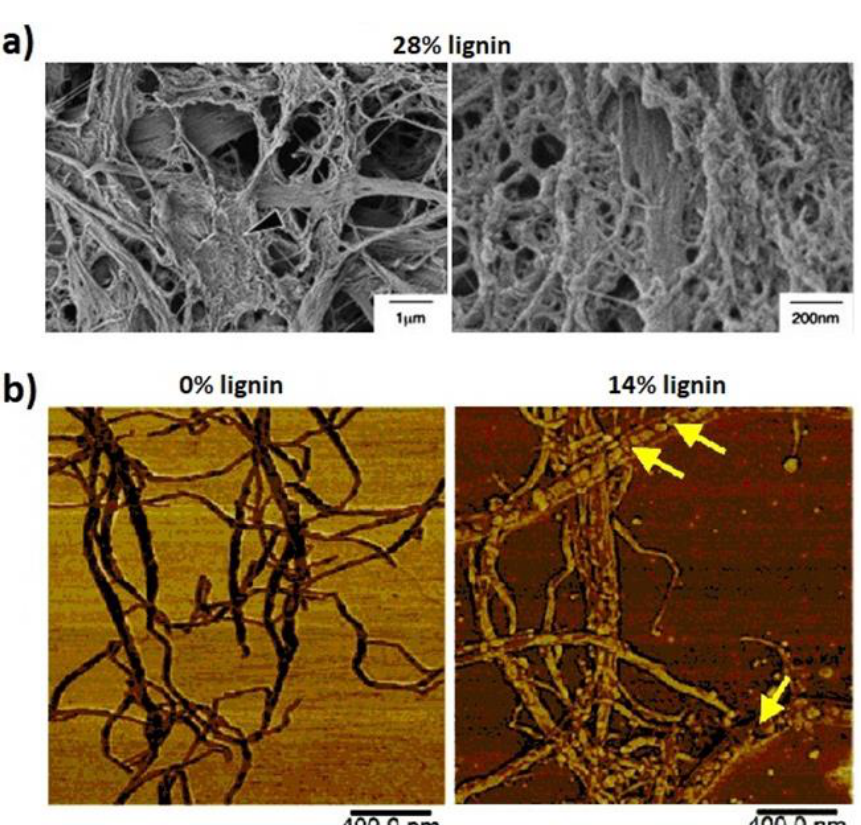
Figure 3. ( a ) SEM images of mechanically fibrillated CTMP (28% lignin) [10]. ( b ) AFM images of LCNF from sulfur dioxide-ethanol-water (SEW) pulp with and without lignin [57]. ( a ) Adapted with permission [10], Copyright 2009, Elsevier Ltd. ( b ) Adapted with permission [57], Copyright 2015, Royal Society of Chemistry.